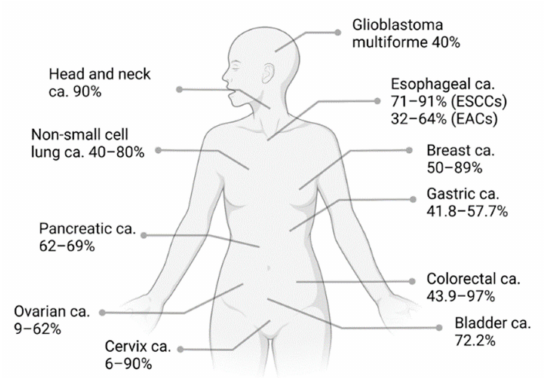
Figure 4. The positivity proportions of EGFR expression in various cancers (ca., carcinoma; ESCC, esophageal squamous cell carcinoma; EAC, esophageal adenocarcinoma). Adapted from Kato et al., Cancers, published by MDPI in 2021. Created with